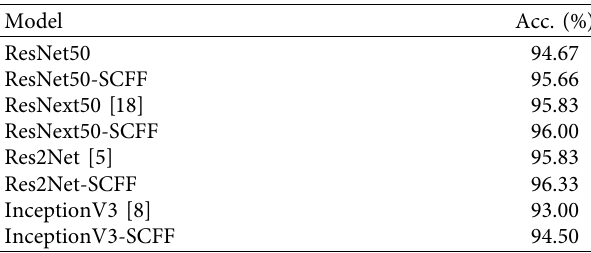
Table 5: The experimental results of SIRI-WHU